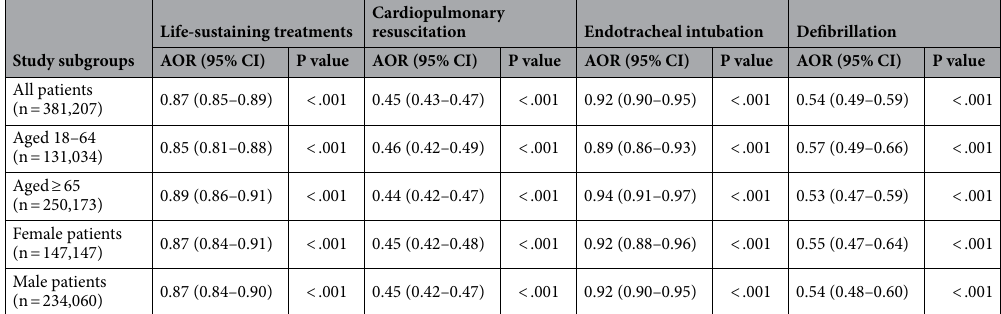
Table 4. Sensitivity analysis for the associations between end-of-life discussions and life-sustaining treatment after adjusting for patient characteristics. AOR, adjusted odds ratio; CI, confident